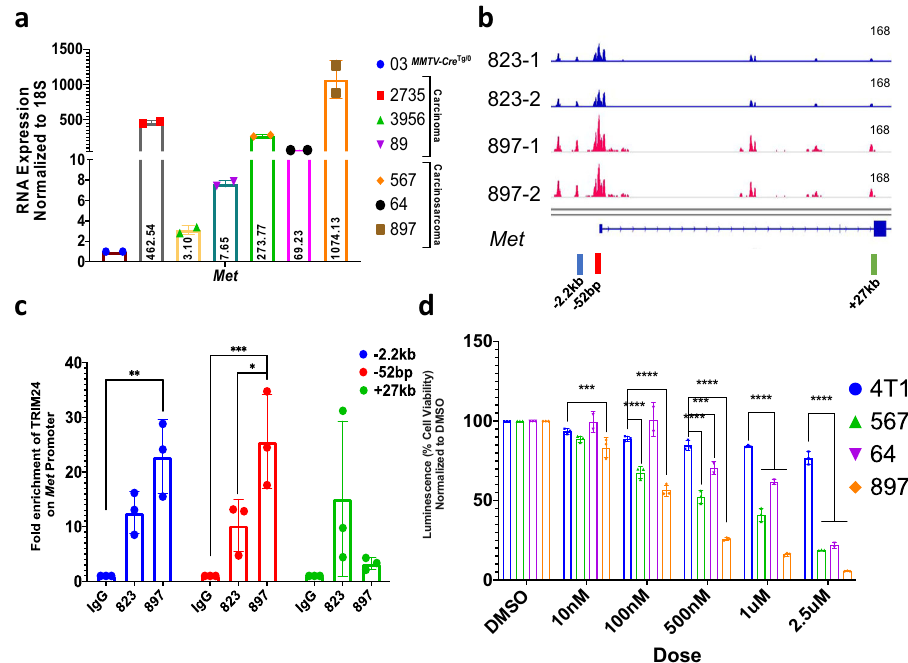
Fig. 5 TRIM24 directly activates c-Met to support metaplastic carcinosarcoma cell viability. a qRT-PCR validation of cMET RNA expression in TRIM24 overexpressing tumors compared to MMTV-Cre Tg/0 mammary gland (03) ( n = 2 technical replicates for each tumor samples). b Snapshot of Integrated Genome Viewer (IGV) showing tracks and peaks of ATAC-Seq-determined chromatin accessibility of MMTV-Cre spontaneous tumor cell line 823 (blue) and TRIM24 overexpressing primary metaplastic carcinosarcoma cell line 897 (red). The scales of the tracks are adjusted to 168. The color bar below the tracks shows positions of primers used to assess TRIM24 interactions with cMET chromatin. c Chromatin immunoprecipitation (ChIP) PCR showing enrichment of TRIM24 on Met promoter to validate ATAC-Seq on 823 and 897 cell lines. The color of each bars indicates primers corresponding to arrows shown in B ( n = 3 biological replicates). (* p = 0.0209, ** p = 0.0014, *** p = 0.0004). d Cell viability assay on 4T1 (mouse TNBC cell line- non-metaplastic) and TRIM24 overexpressing primary cell lines (567, 64, and 897) upon treatment with Crizotinib, an FDA-approved ATP-competitive selective small molecule inhibitor of c-Met and ALK receptor. Percent cell viability is measured using a luminescence reader; values are normalized to DMSO, a vehicle control ( n = 3 biological replicates). Data represented as mean with SD in a , and mean ± SEM in c , d . p -values are calculated in c based on two-way ANOVA for multiple comparisons using Tukey method and in d using two-way ANOVA for multiple comparisons using Holm – Sidak method. (*** p < 0.001, **** p <